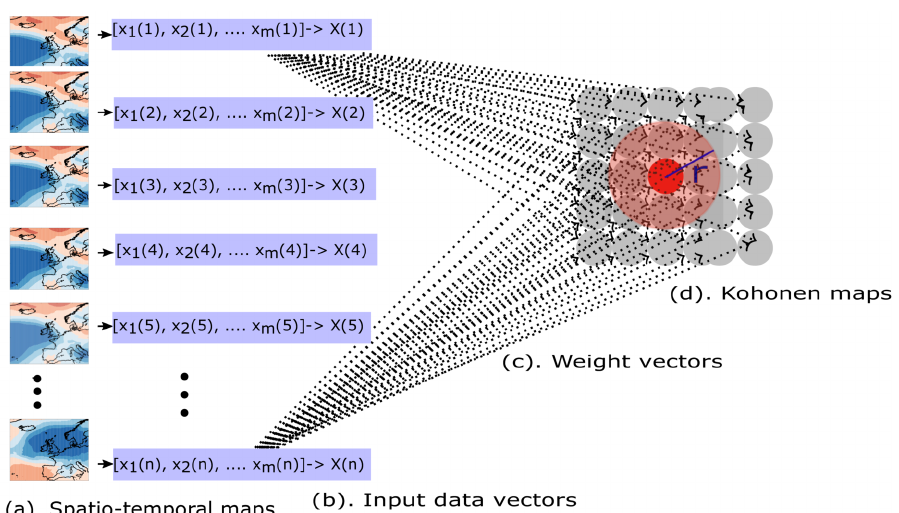
Figure 1. Schematic diagram of SOM: ( a ) n samples of hourly spatial SLP 2D maps containing m grid points ( b ) 2D spatial data converted into 1D vectors, ( c ) weight vectors ( W i ) connecting input data with 2D Kohonen maps, ( d ) SOM topological maps and the neighborhood radius ( σ ). The red dot is a hypothetical Best-Matching Unit (BMU) which has the smallest Euclidean distance between the weight of the output neuron and the input data